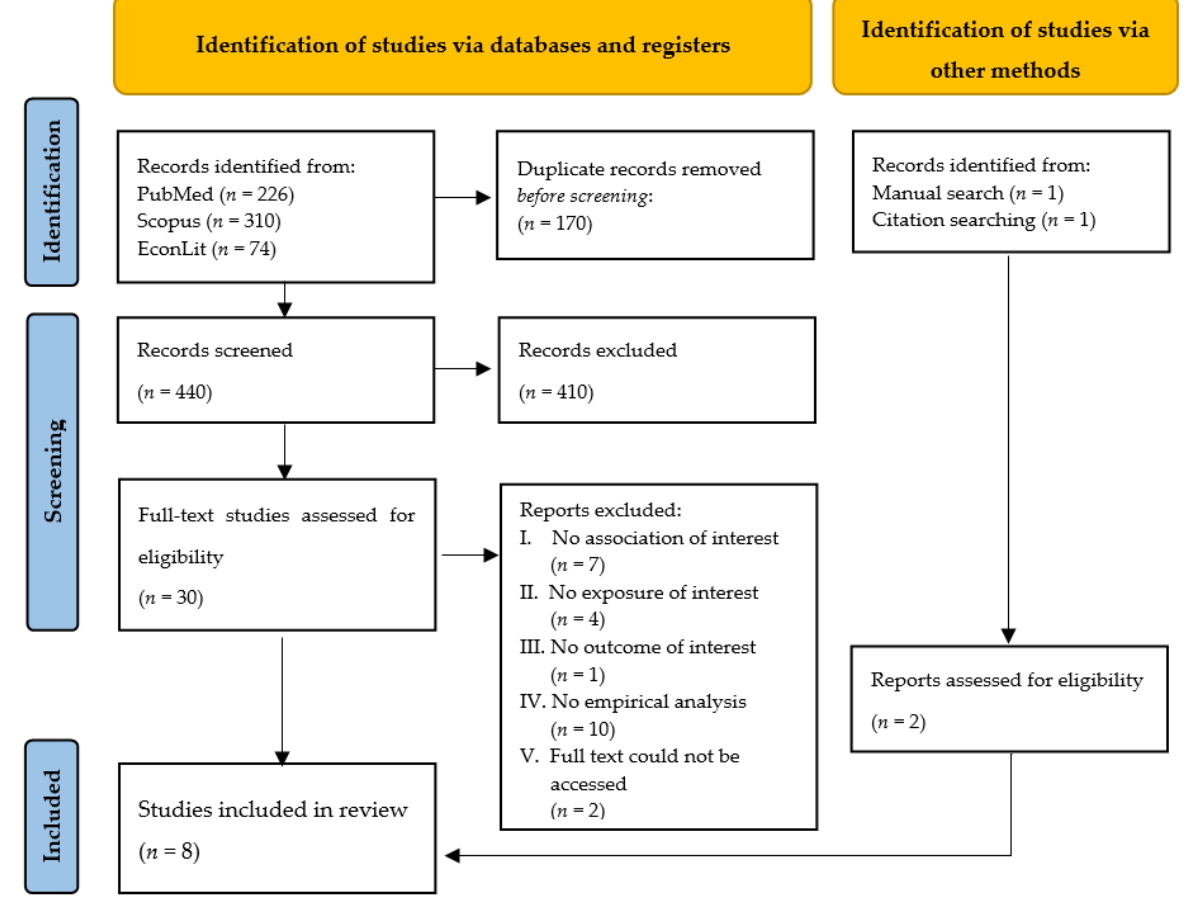
Figure 2. PRISMA 2020 flow diagram of the article selection process.